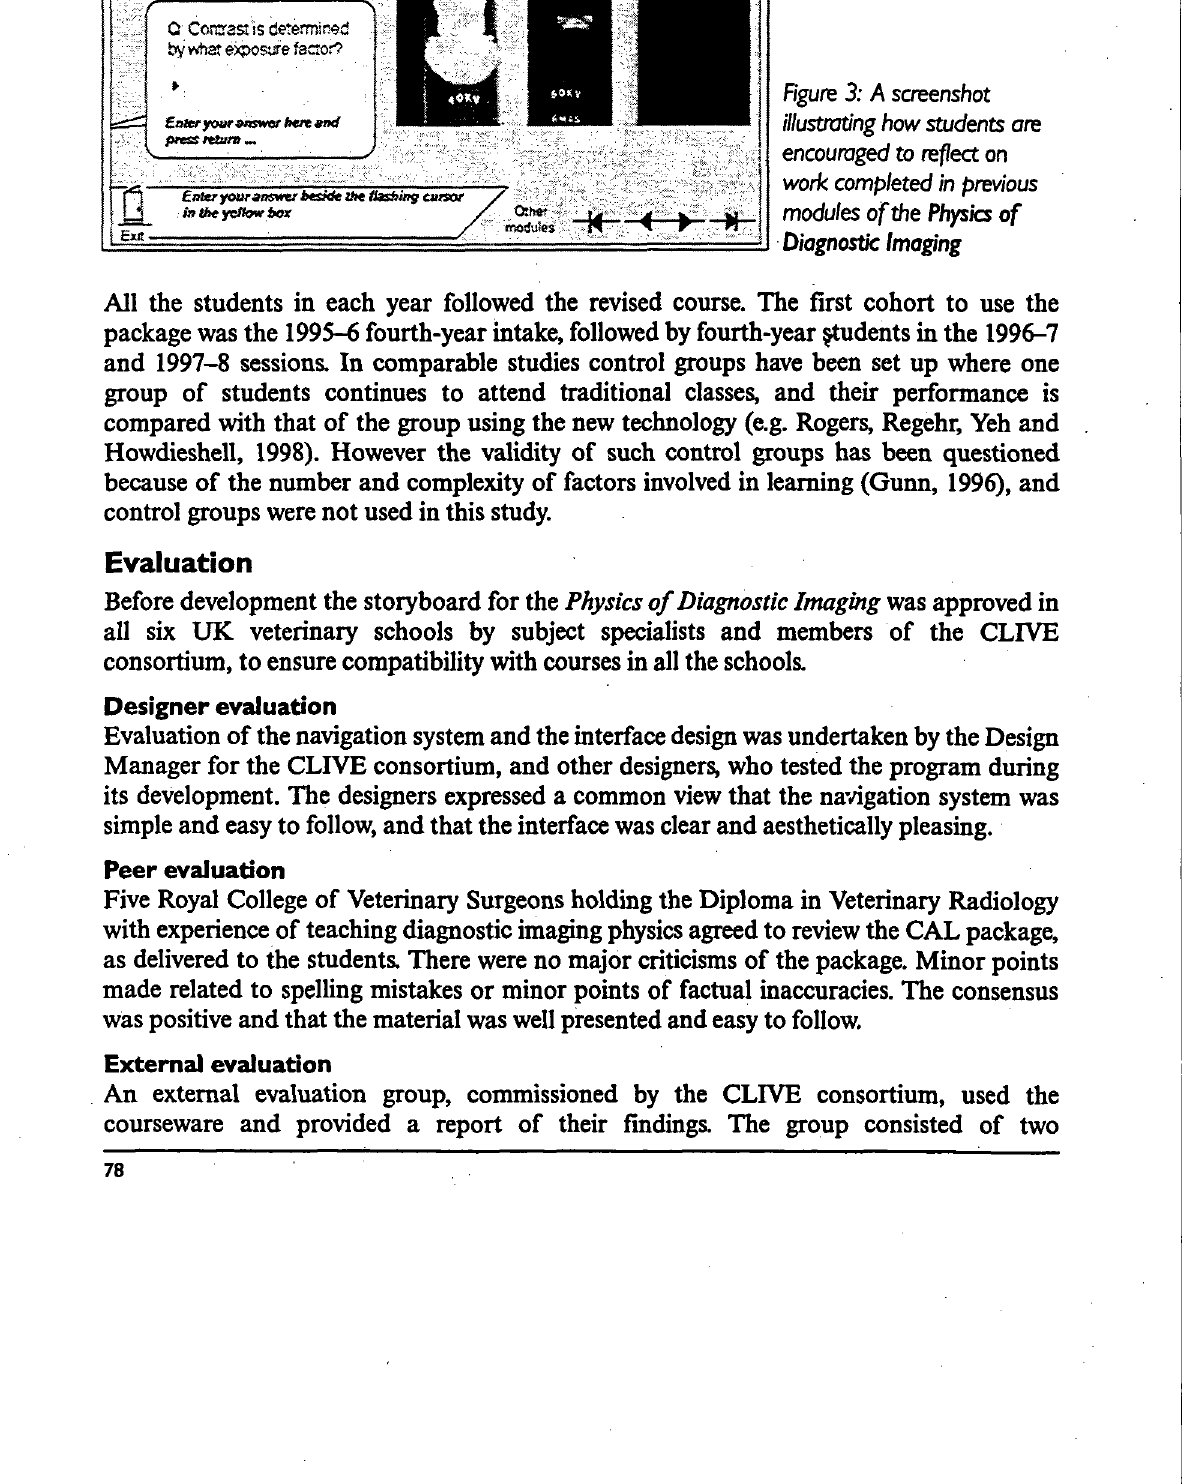
figure 3: A screenshot illustrating how students are encouraged to reflect on work completed in previous modules of the Physics of Diagnostic